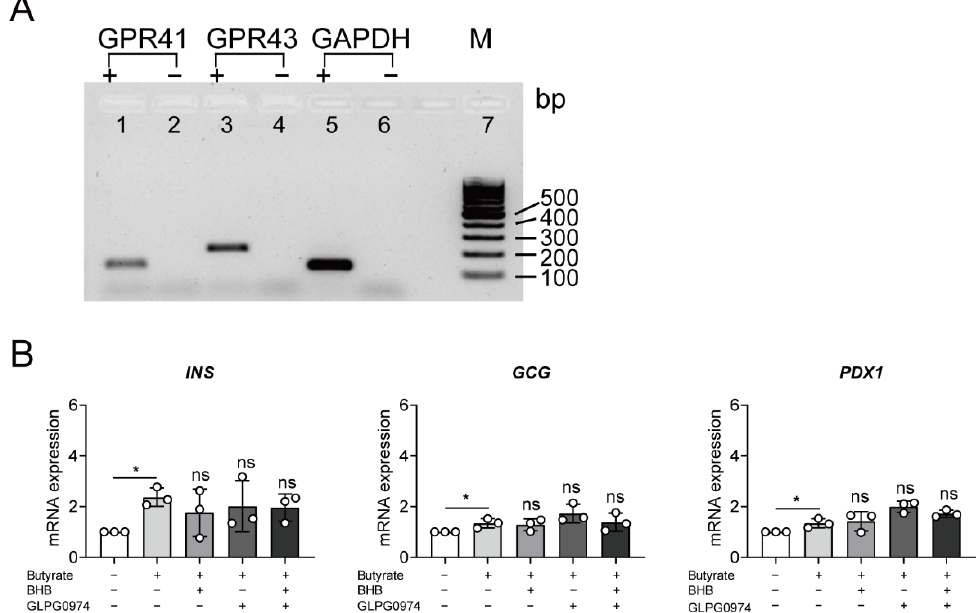
Figure 3. GPR41 and GPR43 are not involved in up-regulation of insulin gene expression by butyrate. ( A ) Expression of GPR41 (119 bp) (lanes 1, 2), GPR43 (197 bp) (lanes 3, 4) and GAPDH (lanes 5, 6) in NPICCs assessed by RT-PCR and agarose gel electrophoresis. Samples without reverse transcriptase ( − ) were included as controls ( B ) NPICCs were cultured in B-IC medium with 1000 µM butyrate for six days containing GPR41 inhibitor (5 mM β -hydroxybutyrate, BHB), or GPR43 inhibitor (200 nM GPLG0974) or both as indicated. The mRNA levels of INS, GCG and PDX1 were examined by RT-qPCR. Cells without butyrate exposure were used as controls. Data are presented as mean ± SD of three independent experiments. * p < 0.05 vs. control group. ns = not